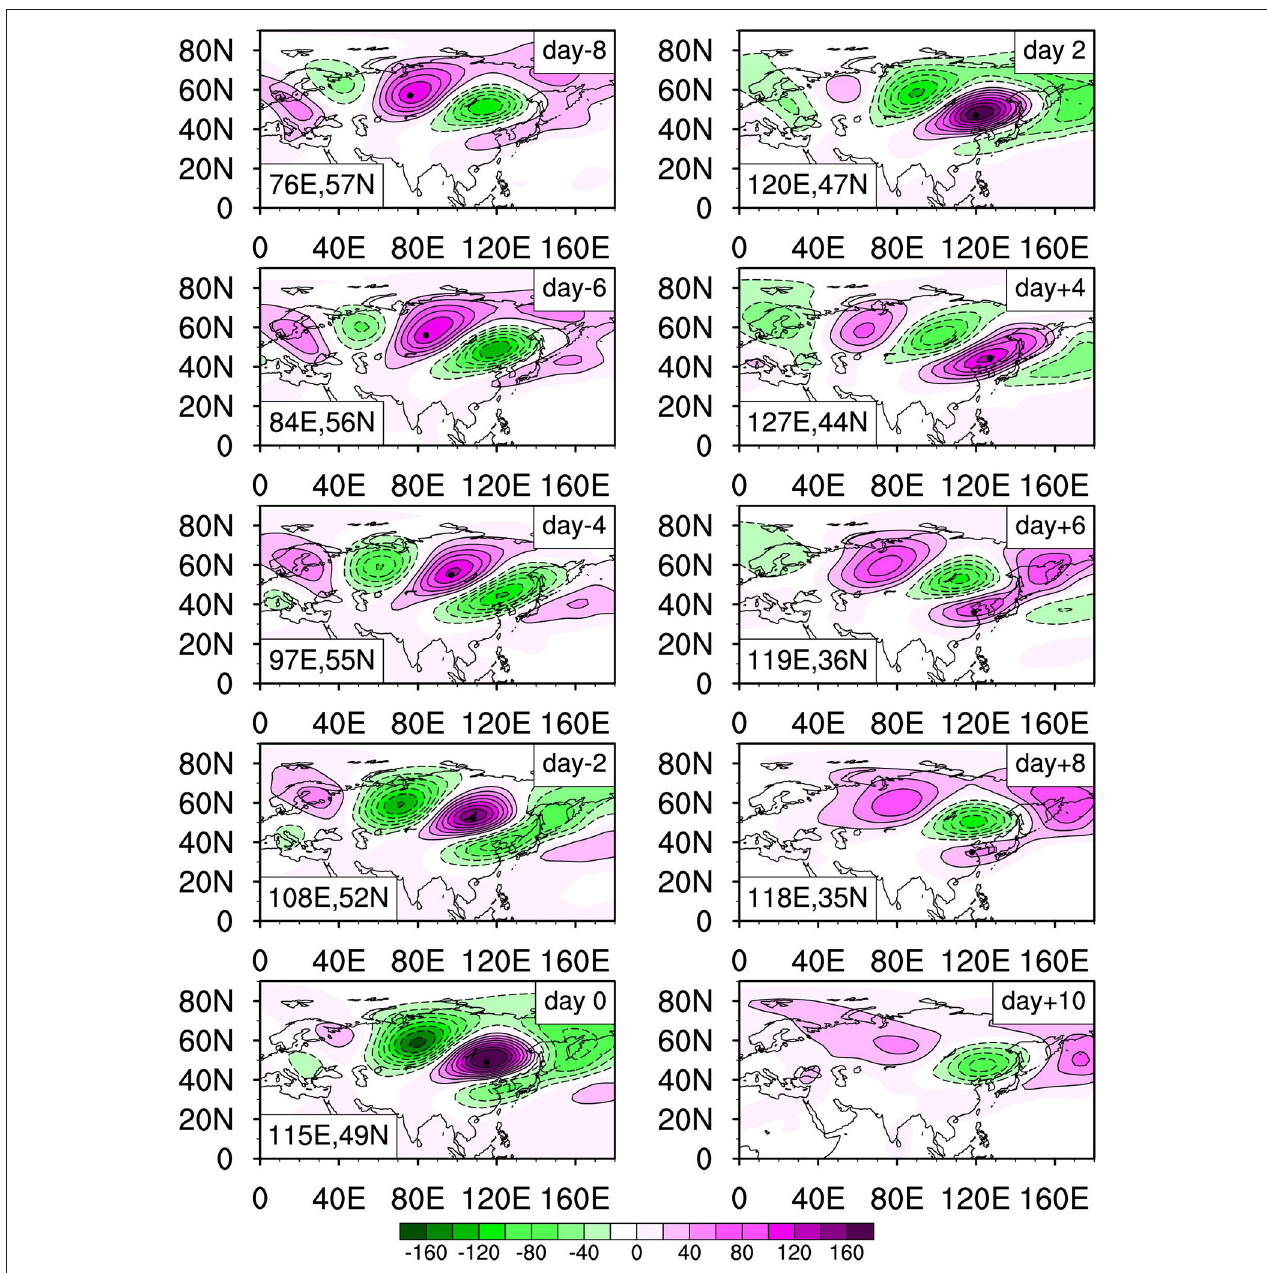
FIGURE 7 | As in Figure 4 , but for 10–30-day filtered geopotential height anomaly (shading; unit: gpm) at 250 hPa from day − 8 to day +